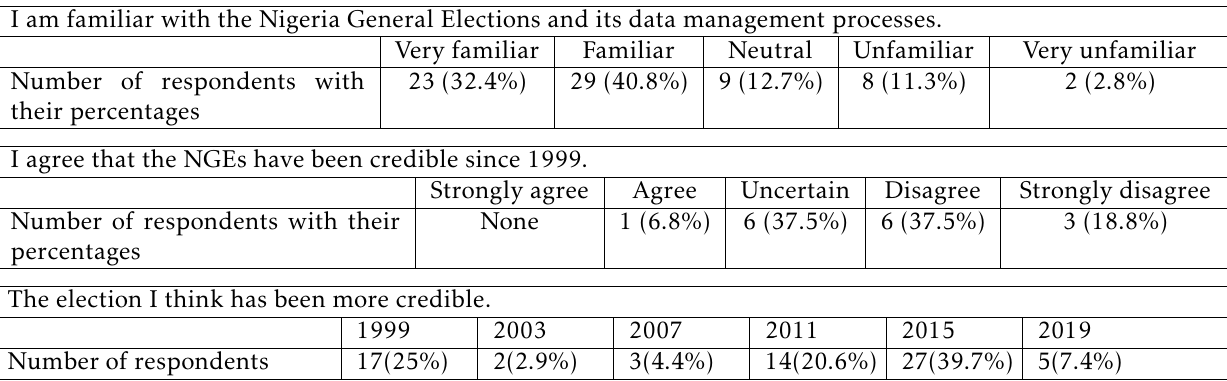
Table 1. Participants’ knowledge related to Nigeria General